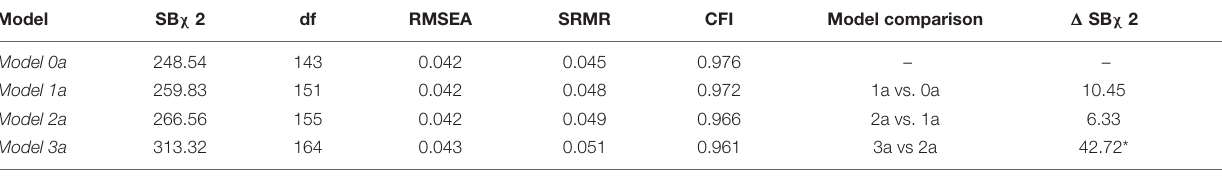
TABLE 5 | Fit indices of the nested models for testing the measurement invariance by gender.